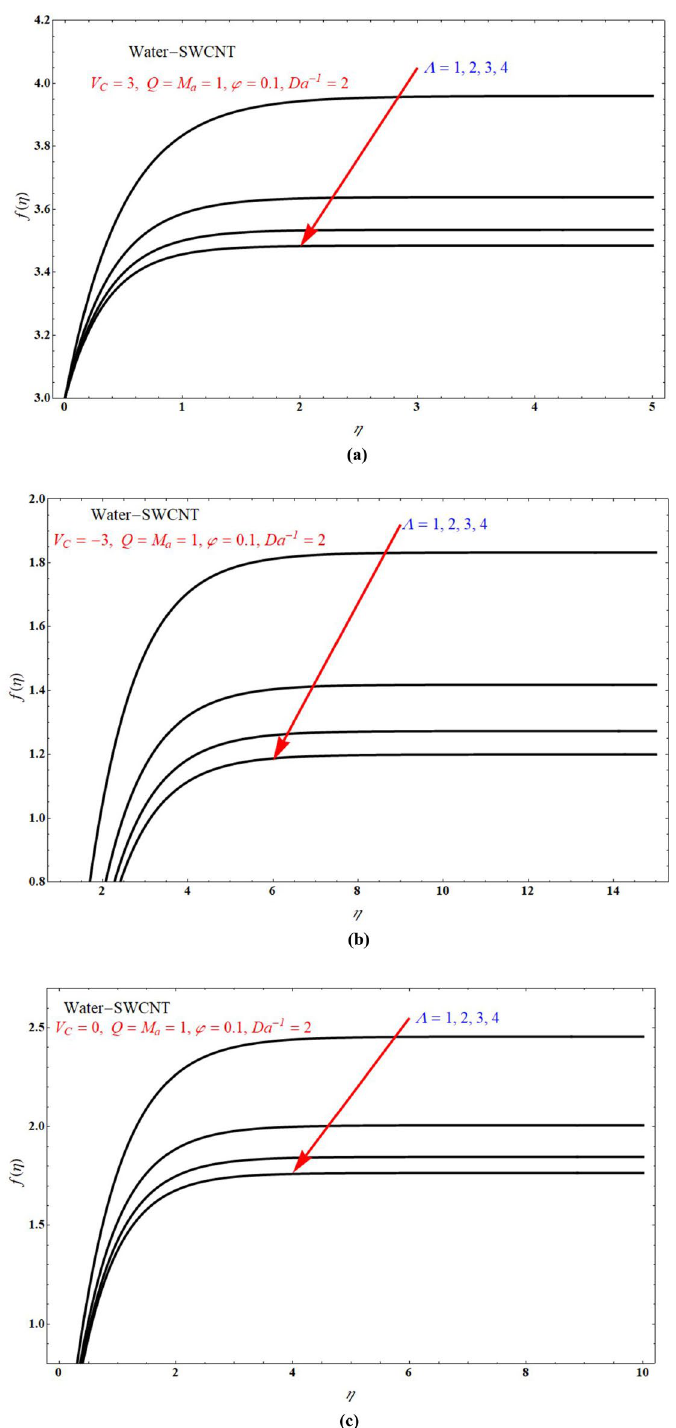
Figure 6. f (η) verses η for various values of (cid:31) at ( a ) V C = 3 , ( b ) V C = − 3 and ( c ) V C = 0